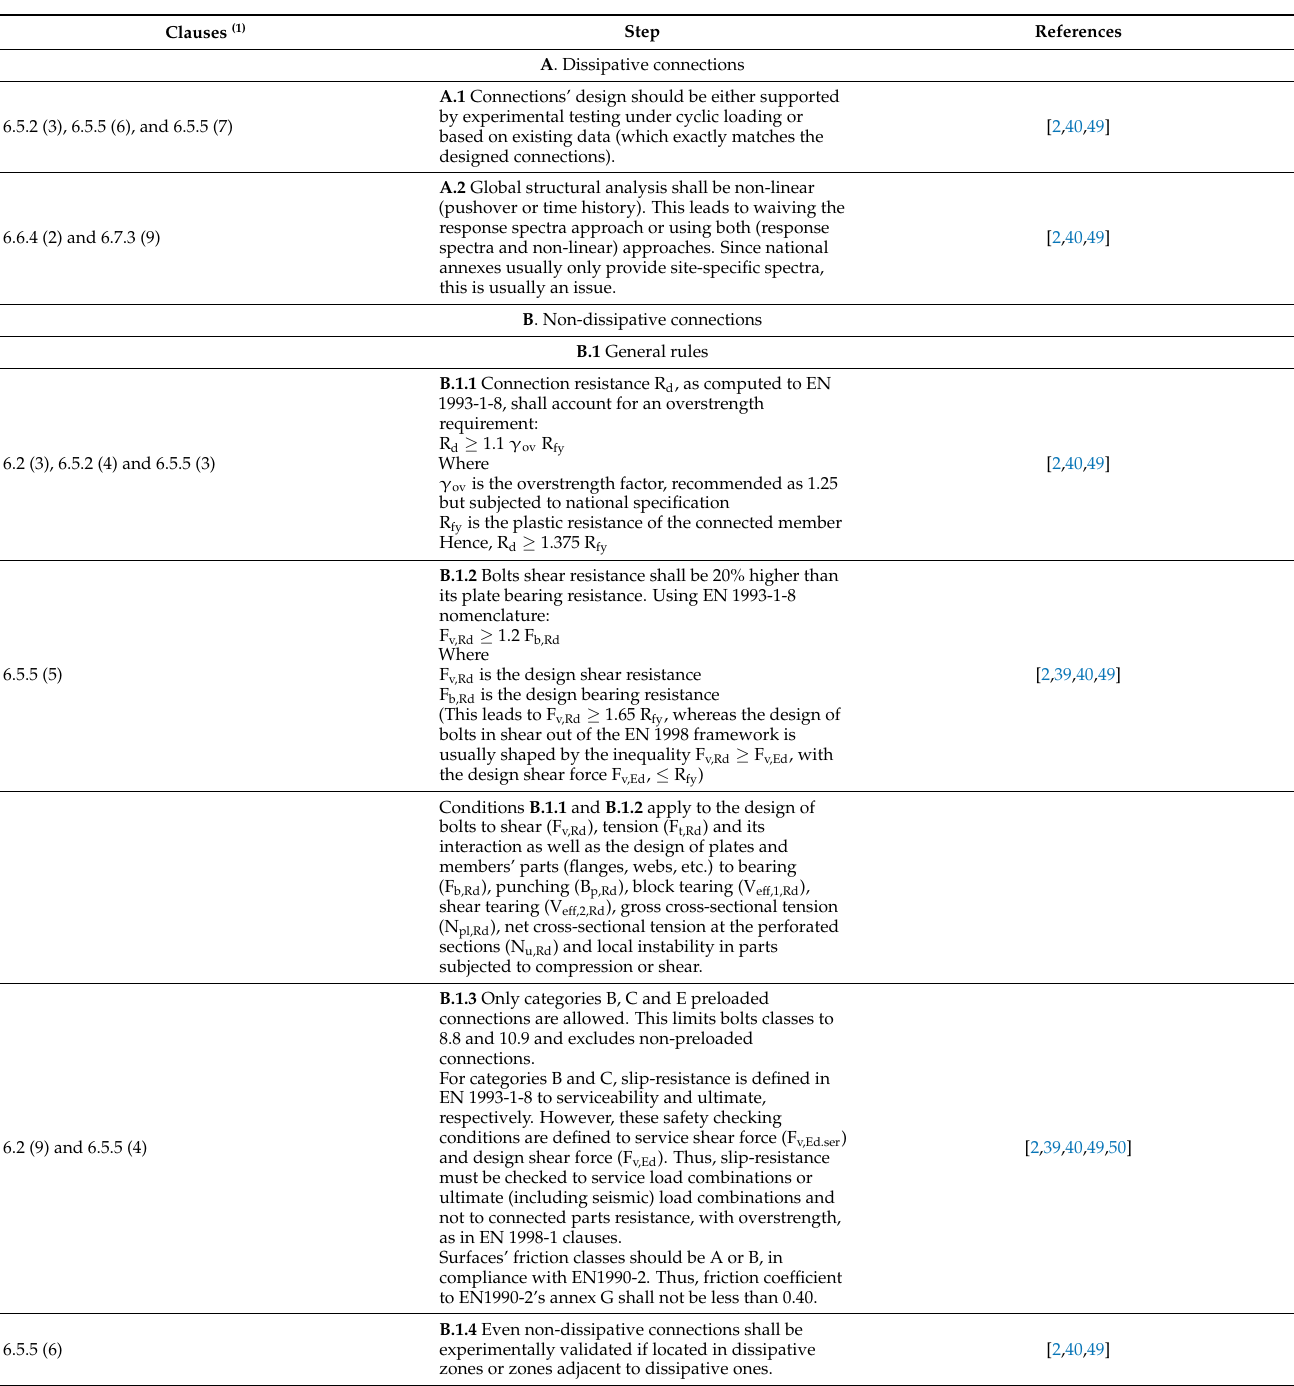
Table 2. Steps of practical seismic design of bolted steel connections according to